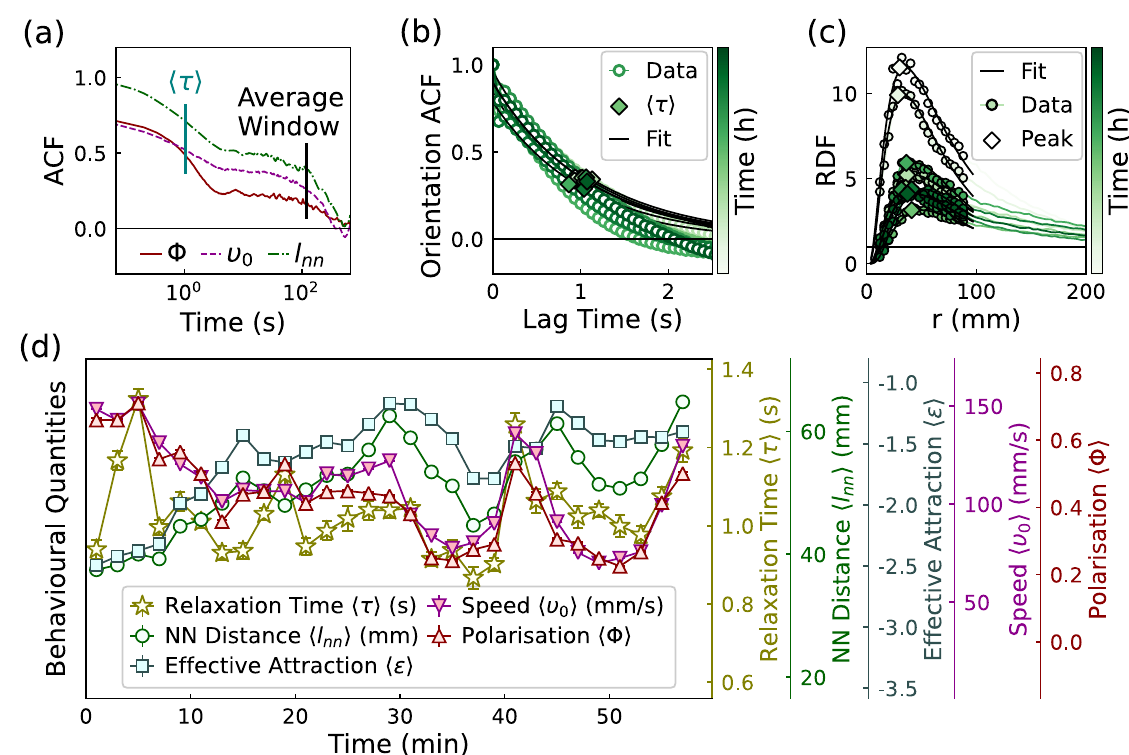
Fig 2. The behavioural quantities of 50 young zebrafish (group Y1). A: The auto–correlation function of the polarisation and average speed of the fish group. B: The auto–correlation function of the orientations of fish. C: Sequence of radial distribution functions with increasing time: at early times (top curves) the fish are clustered together so that the peak is large; at later times (bottom curves) the local density decreases and so does the peak height. D: The time evolution of the averaged behavioural quantities for 50 young fish. Each point corresponds to the average value in 2 minutes. The error bars illustrate the standard error values.